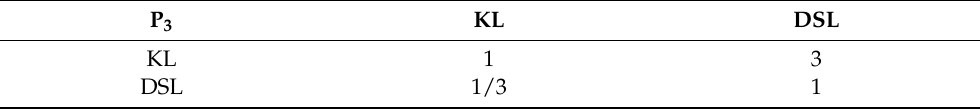
Table 5. Pairwise comparison matrix of index